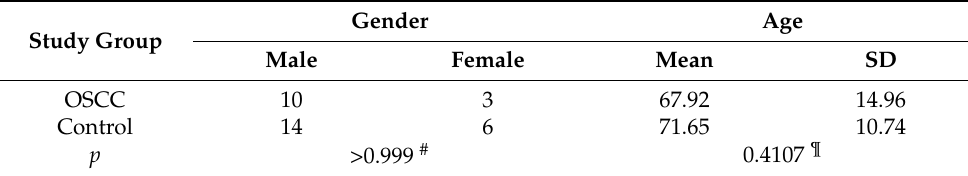
Table 1. General characteristics of the study groups.